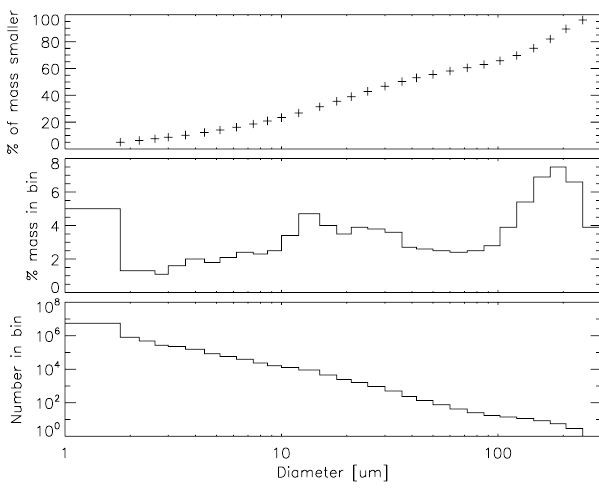
Fig. 2. Size distribution of the Ey0 ash sample collected on 15 April 2010. Top panel: percentage of sample mass made up of particles smaller than the diameter value on the x -axis. Centre panel: per- centage of sample mass made up by particles in a certain size bin (with bin sizes indicated by the width of the bars; the lowest mea- sured diameter bin, 1.8µm also contains the mass of all smaller par- ticles). Bottom panel: number of particles in each size bin (with particles smaller than 1.8µm diameter counted in the 1.8µm